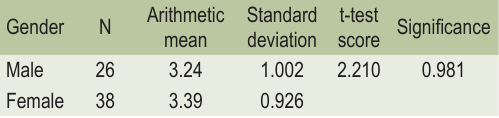
TABLE 3. General opinion about the value of development of managers, as a factor that affects communication in health- care. The data given is for the Healthcare center Sarajevo Canton.